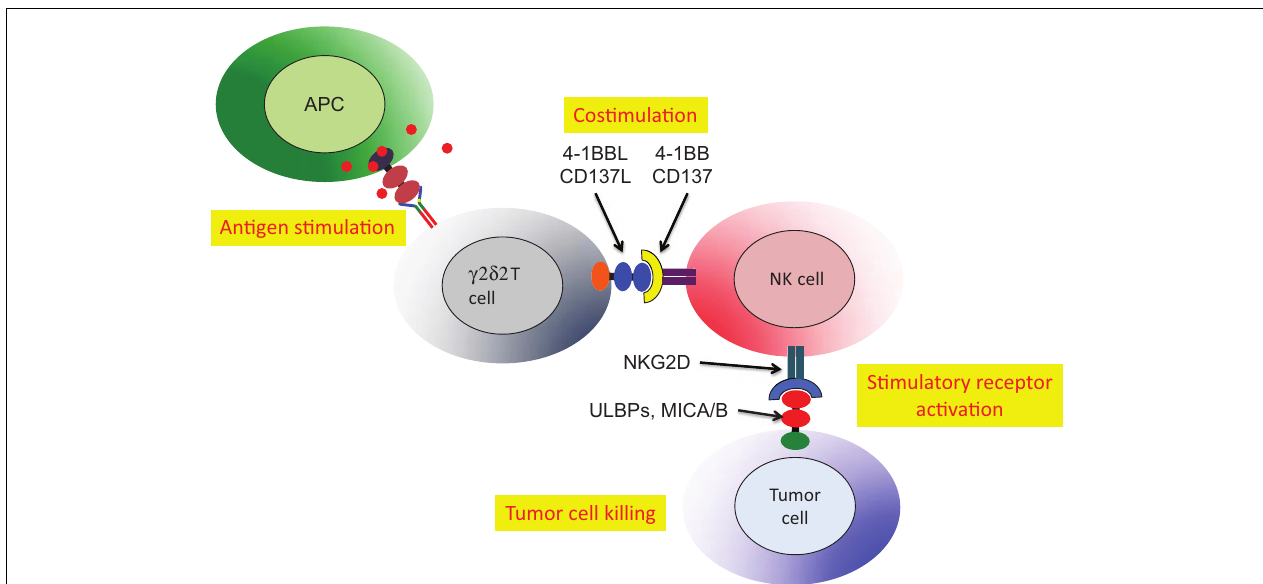
FIGURE 4 | StimulatedV δ 2T cells co-stimulate NK to increase tumor cell cytolysis . ActivatedV δ 2T cells express 4-1BBL that binds 4-1BB on NK cells. The NKG2D receptor on NK is upregulated allowing stronger recognition of